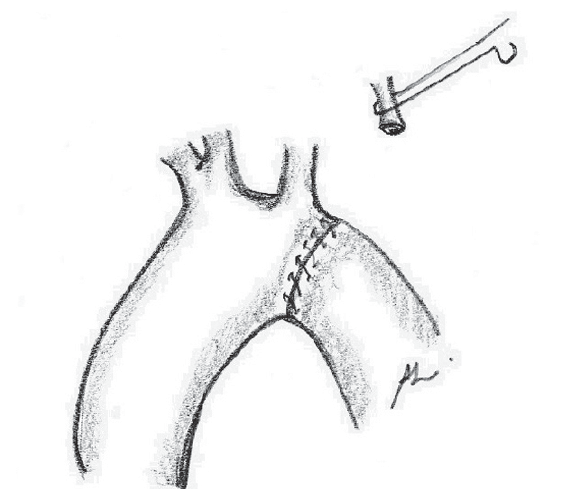
Fig. 7- Anastomose término-terminal entre a crossa e aorta descendente